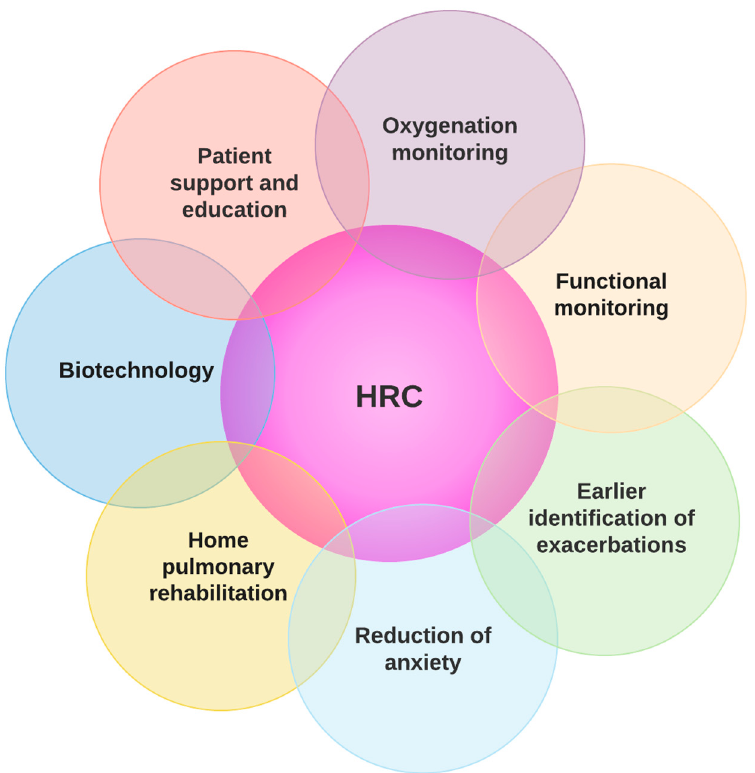
Figure 1. Home-based respiratory care as a multidimensional health strategy for COPD; HRC: home-based respiratory care.